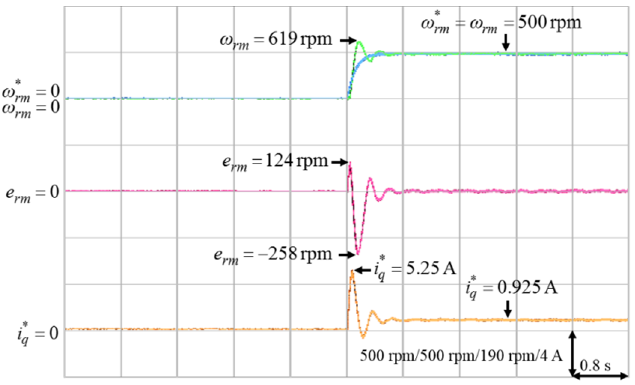
Figure 6. Experimental results of ACSM speed controller from standstill to 500 rpm in Case 2 .